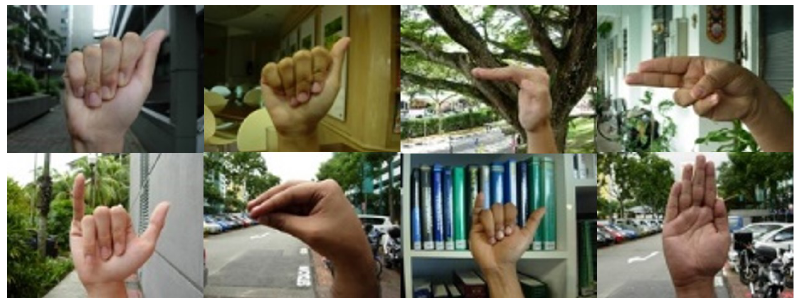
Figure 8. Sample images from NUS Hand Posture dataset.